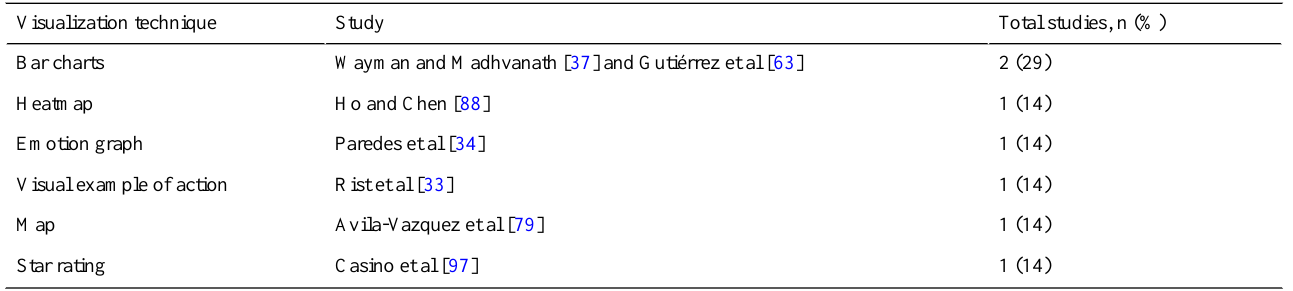
Table 4. Distribution of the visualizations used among the different health recommender systems